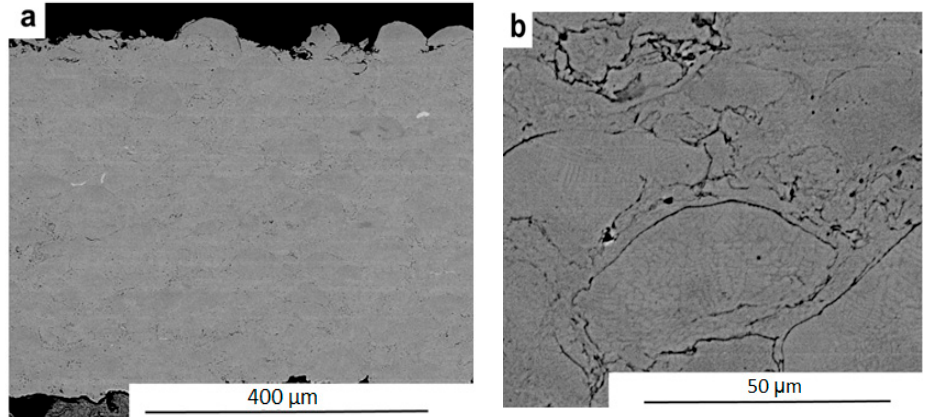
Figure 2. The scanning electron microscope (SEM) microstructure of Stellite 6 (Co-Cr-W alloy)) High pressure (HP)/High velocity oxy-fuel sprayed coating (HVOF) sprayed coating: ( a ) overview; ( b ) detail.